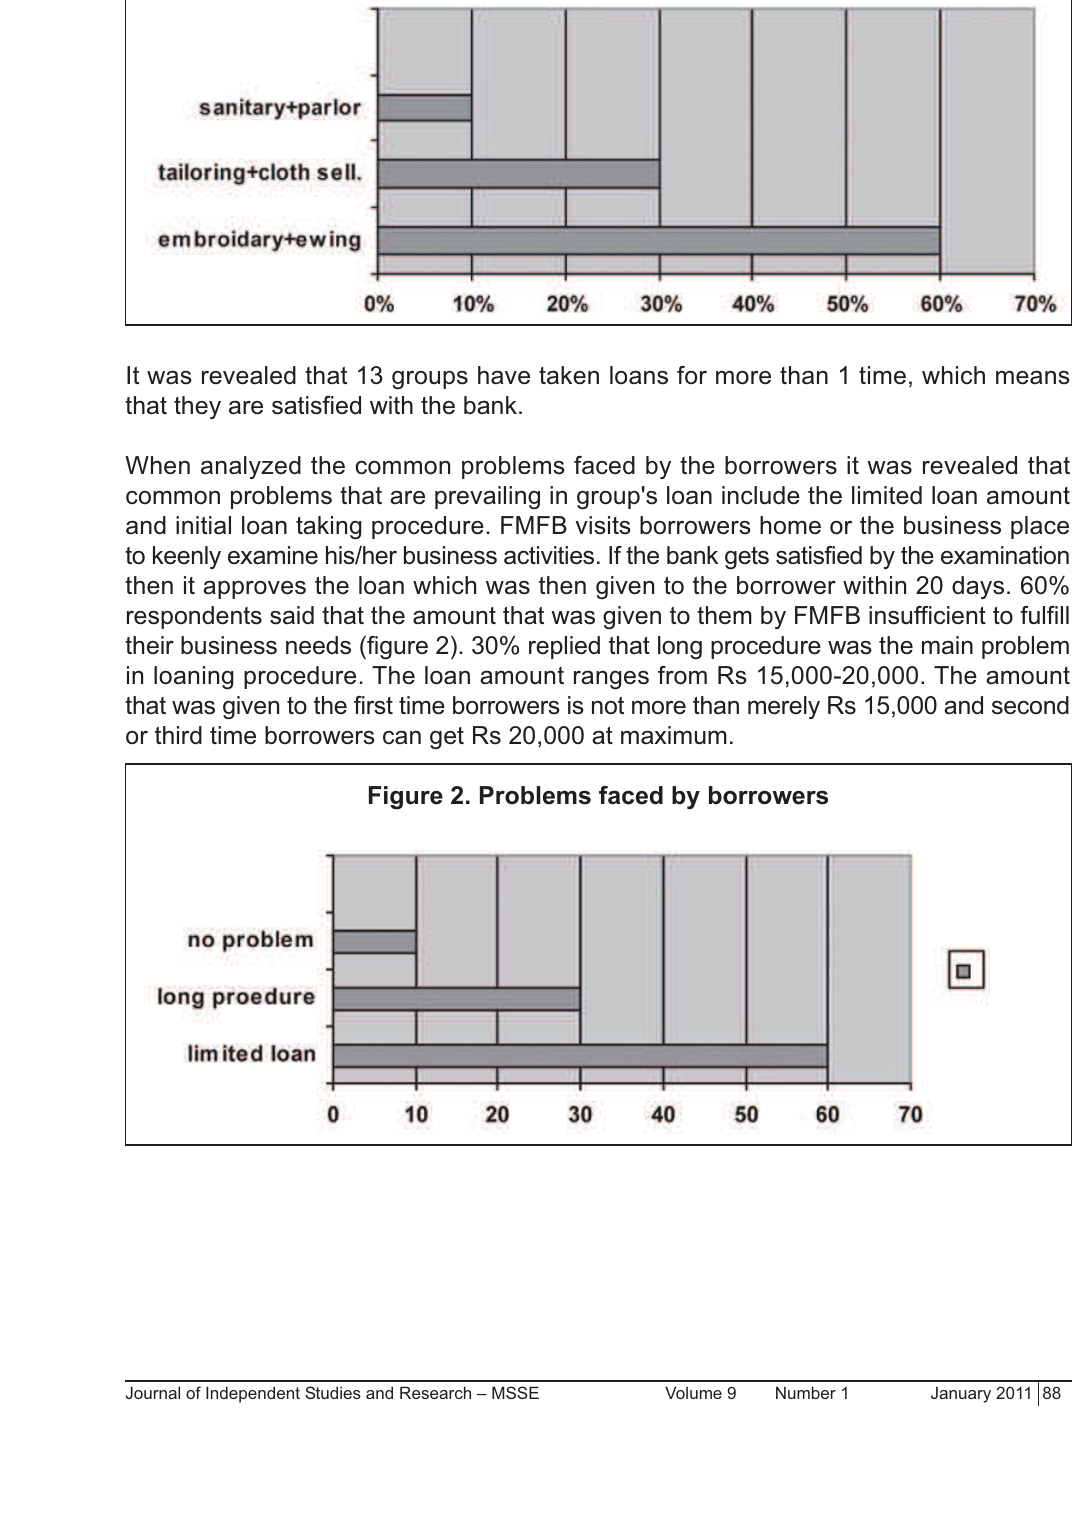
Figure 1. Composition of businesses by borrowers